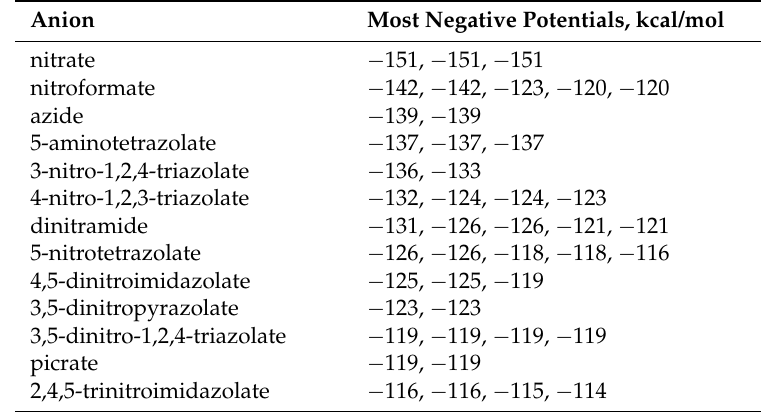
Table 2. Most negative electrostatic potentials on the 0.001 au surfaces of some C,H,N,O mononegative anions. Anion Most Negative Potentials, kcal/mol nitrate ´ 151, ´ 151, ´ 151 nitroformate ´ 142, ´ 142, ´ 123, ´ 120, ´ 120 azide ´ 139, ´ 139 5-aminotetrazolate ´ 137, ´ 137, ´ 137 3-nitro-1,2,4-triazolate ´ 136, ´ 133 4-nitro-1,2,3-triazolate ´ 132, ´ 124, ´ 124, ´ 123 dinitramide ´ 131, ´ 126, ´ 126, ´ 121, ´ 121 5-nitrotetrazolate ´ 126, ´ 126, ´ 118, ´ 118, ´ 116 4,5-dinitroimidazolate ´ 125, ´ 125, ´ 119 3,5-dinitropyrazolate ´ 123, ´ 123 3,5-dinitro-1,2,4-triazolate ´ 119, ´ 119, ´ 119, ´ 119 picrate ´ 119, ´ 119 2,4,5-trinitroimidazolate ´ 116, ´ 116, ´ 115, ´